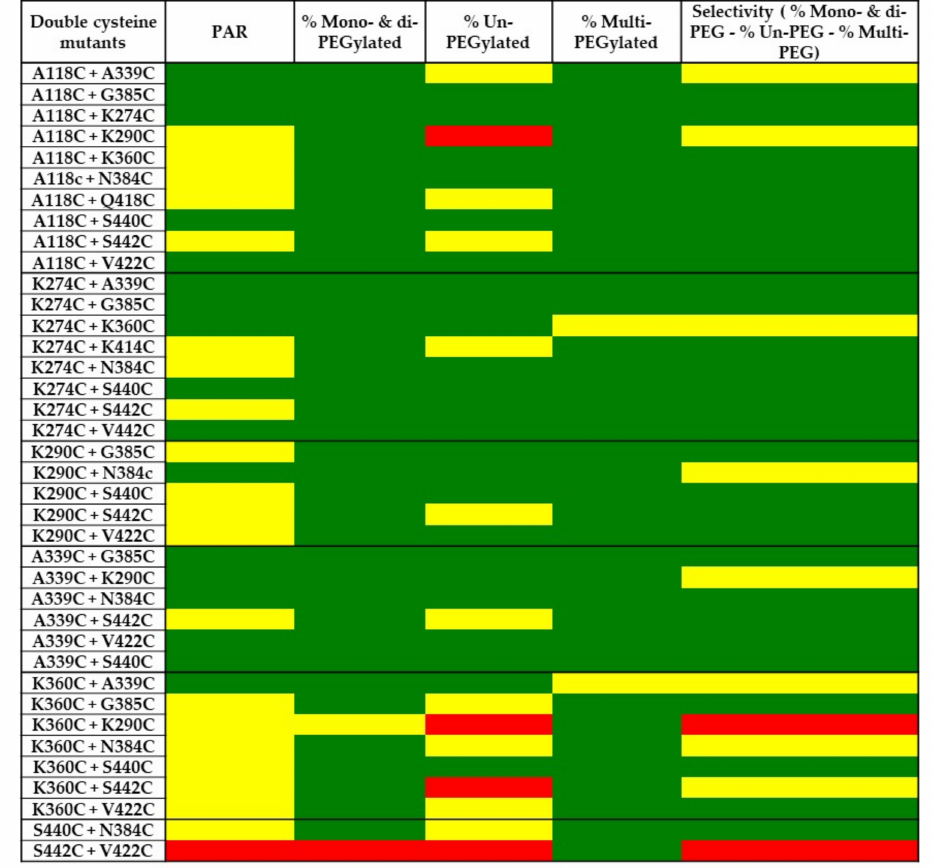
Figure 8. Heatmap of PEGylated double cysteine mutants. Different colors represent ranges of PAR, mono- and di- PEGylated, multi-PEGylated, and un-PEGylated species. PAR: > 3.4 Green < 4; ≥ 2.5 Yellow < 3.4; > 0 Red < 2.5. Mono- and di-PEGylated: > 80% Green < 100%; ≥ 30% Yellow < 80%; > 5% Red < 30%. Un-PEGylated: ≤ 5% Green > 0%; > 5% Yellow ≤ 10%; > 10% Red < 100%. Multi-PEGylated: < 10% Green > 0%; > 10% Yellow < 20%; > 20% Red < 100%. Selectivity (selectivity = % mono- and di-PEG—% un-PEG—% multi-PEG): ≥ 70% Green < 100%, ≥ 60% yellow < 70%, > 0% red <